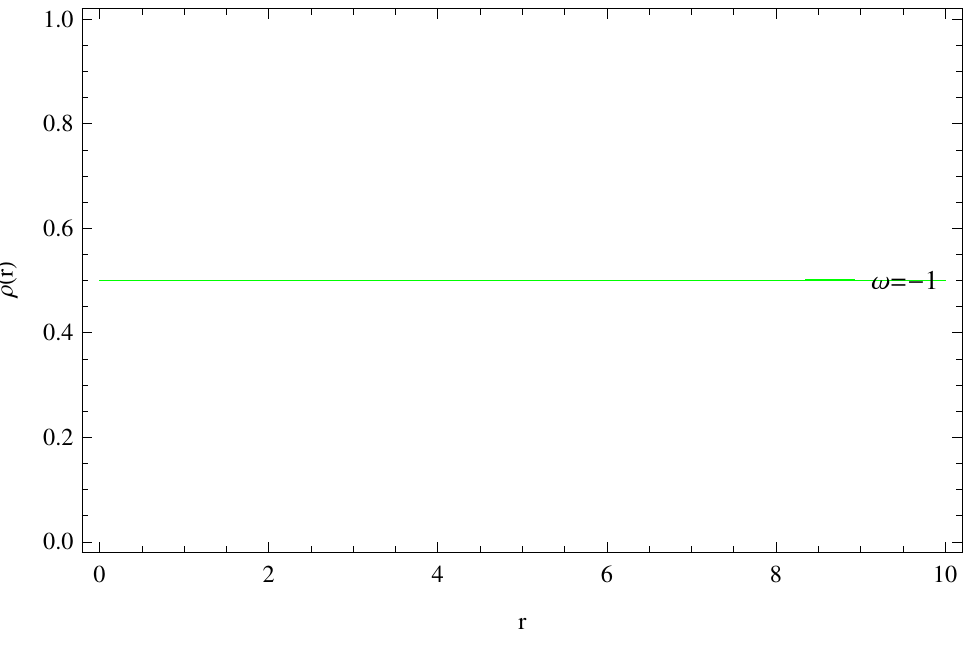
Figure 13. The density is plotted against the radial parameter r with the values of arbitrary constants C 3 = 2, C 4 = 0.001, C 5 =